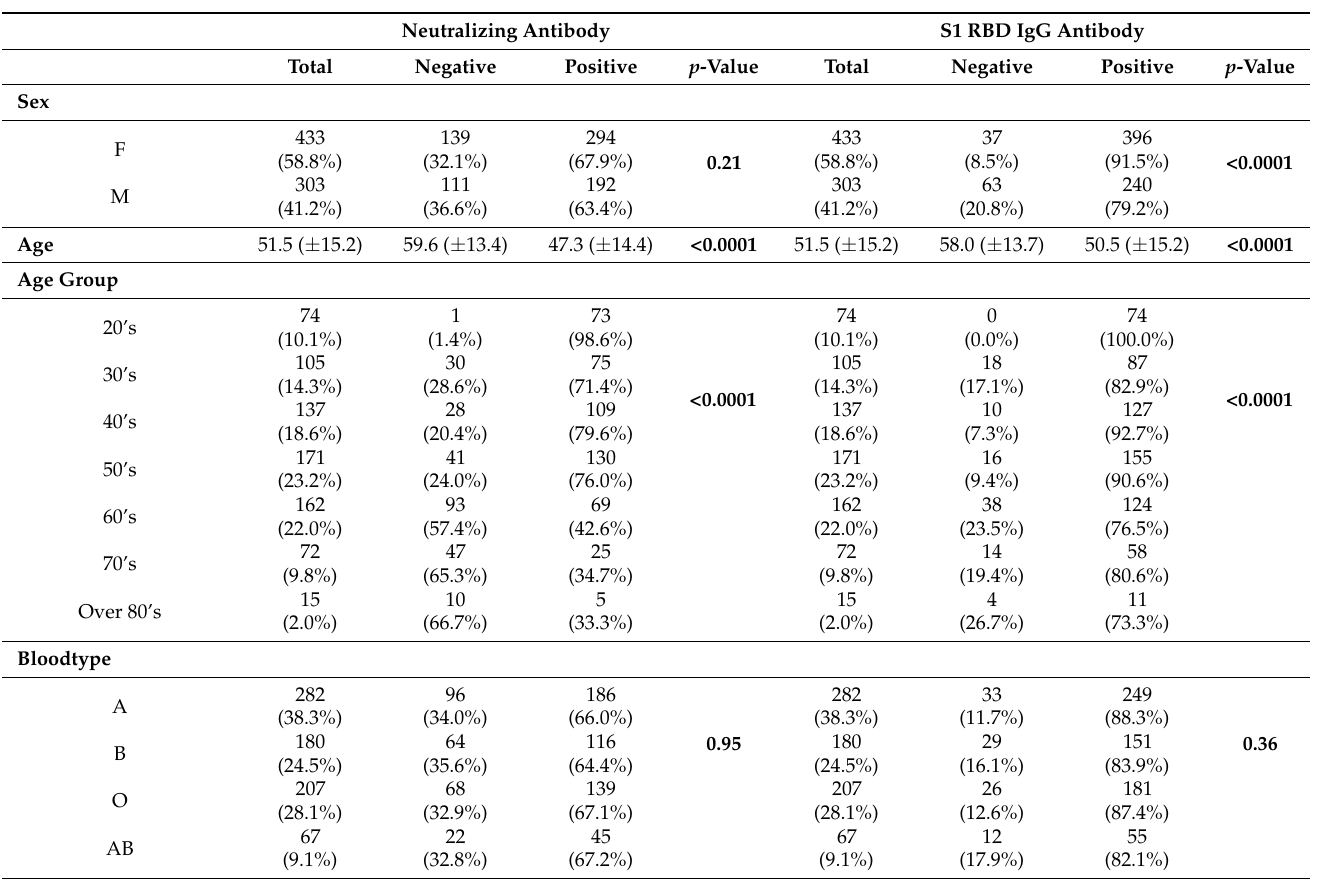
Table 2. Analysis of general antibody and neutralizing antibody production rate according to various